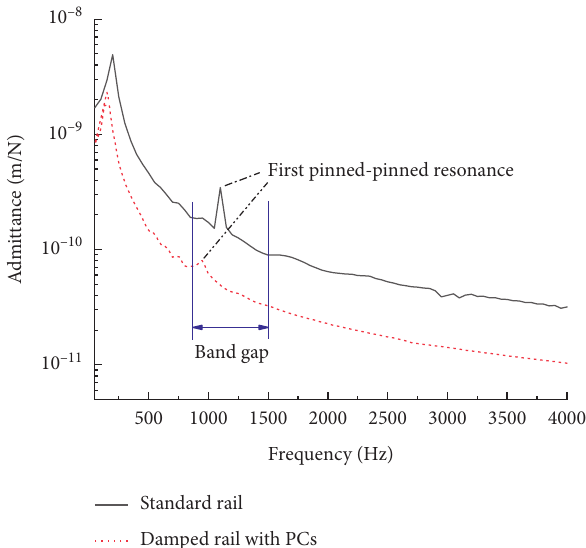
Figure 8: Vertical displacement admittances of standard rail and damped rail with PCs at excitation point.